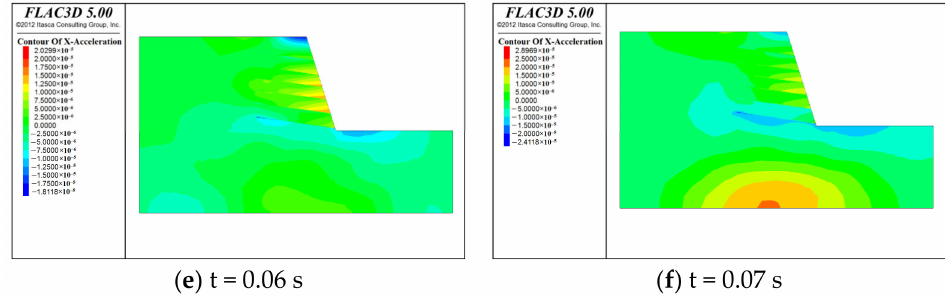
Figure 7. Wave propagation characteristics through the slope when input wave is in z -direction.